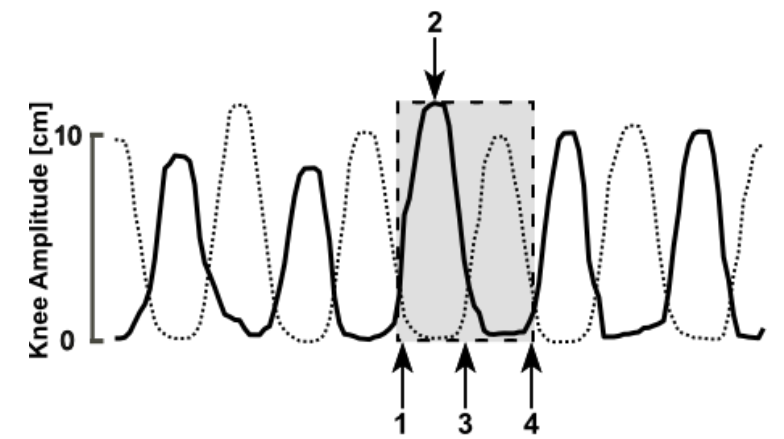
Figure 2. Recorded depth data of a masked participant ( left ) with 25 artificial anatomical landmarks ( right ) provided by the Kinect SDK.